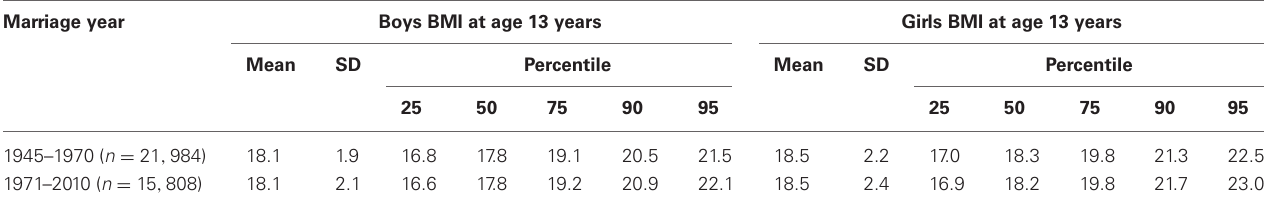
Table 1 | BMI distributions according to two periods of marriage year—before and during the obesity